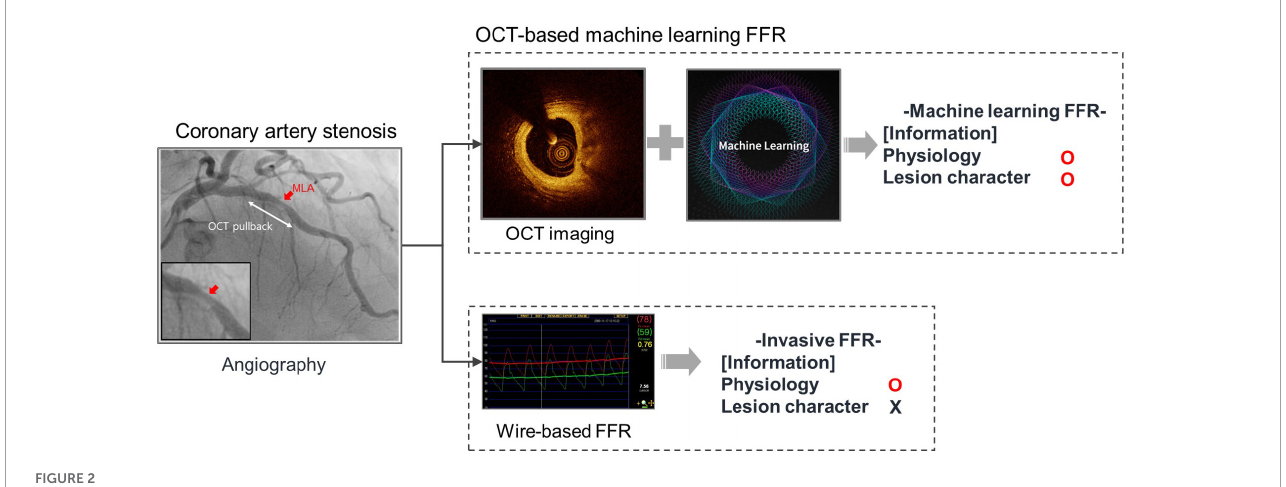
FIGURE2 Advantage of OCT-based machine learning